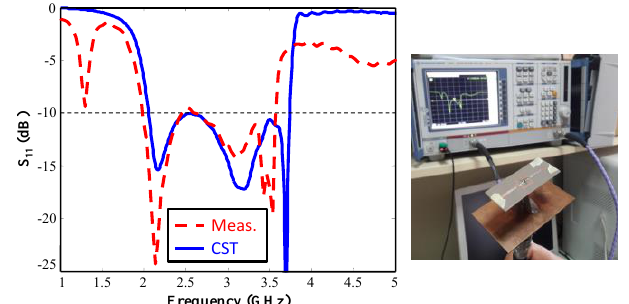
Figure 4: The return loss characteristics of the design: the CST simulation, and the measured result for the fabricated antenna are shown The computed radiation patterns of the proposed MDA are shown in Fig. 5. As seen, the antenna has a directional radiation pattern performance whole band of the interest in both φ = 0° and φ = 90° planes.